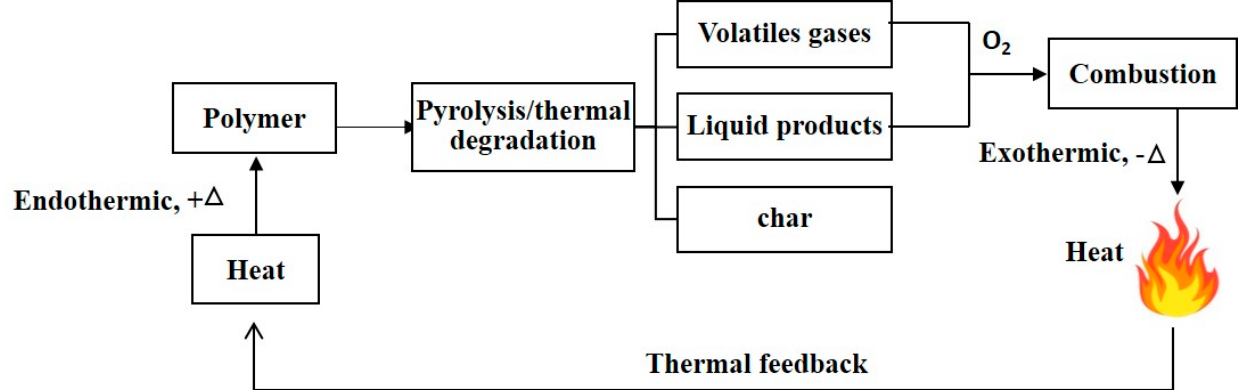
Figure 1. Combustion process.